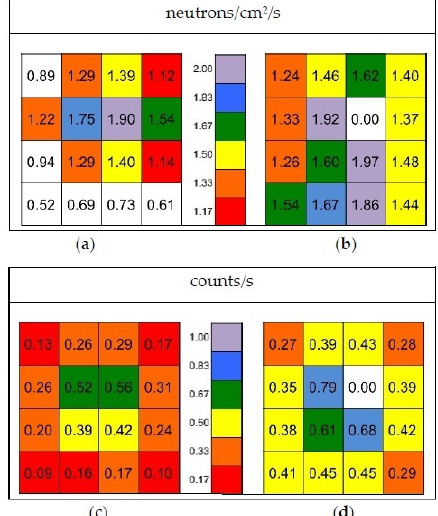
Fig. 6. (a) Total neutron flux simulated in the top position in correspondence of the 4 × 4 SiLiF array; (b) The measured total neutron flux with the 4 × 4 array. (c) The simulated neutron counting rates. (d) The measured neutron counting rates.